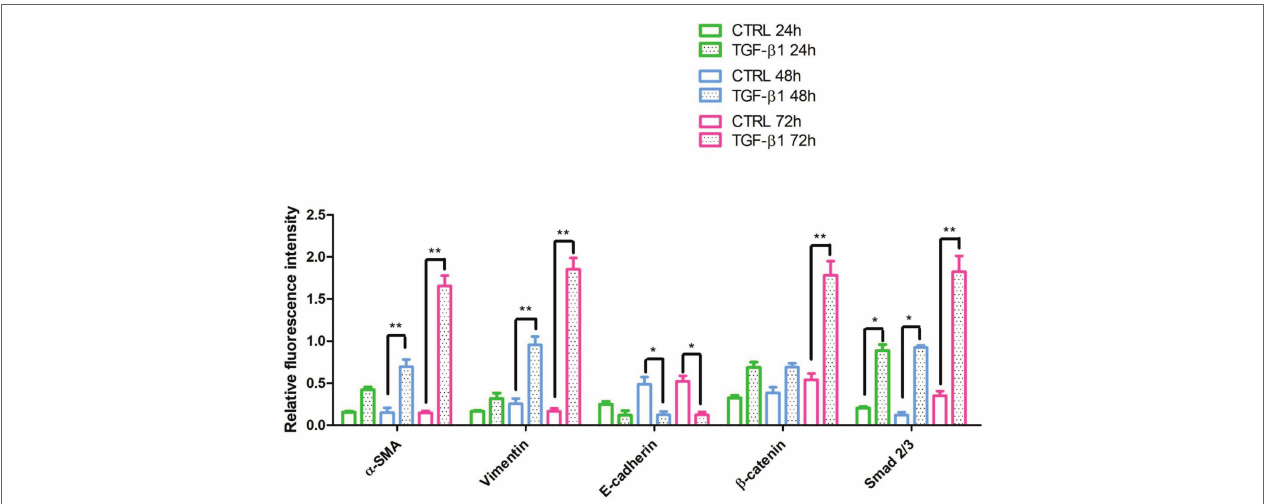
FIGURE 6 | The relative fluorescent intensity of α -SMA, Vimentin, E-caderin, β -catenin, and Smad 2/3 was analyzed using NIS-Elements AR imaging software. Data are presented as the mean of 10 measurements ± SD. * p < 0.05; ** p <